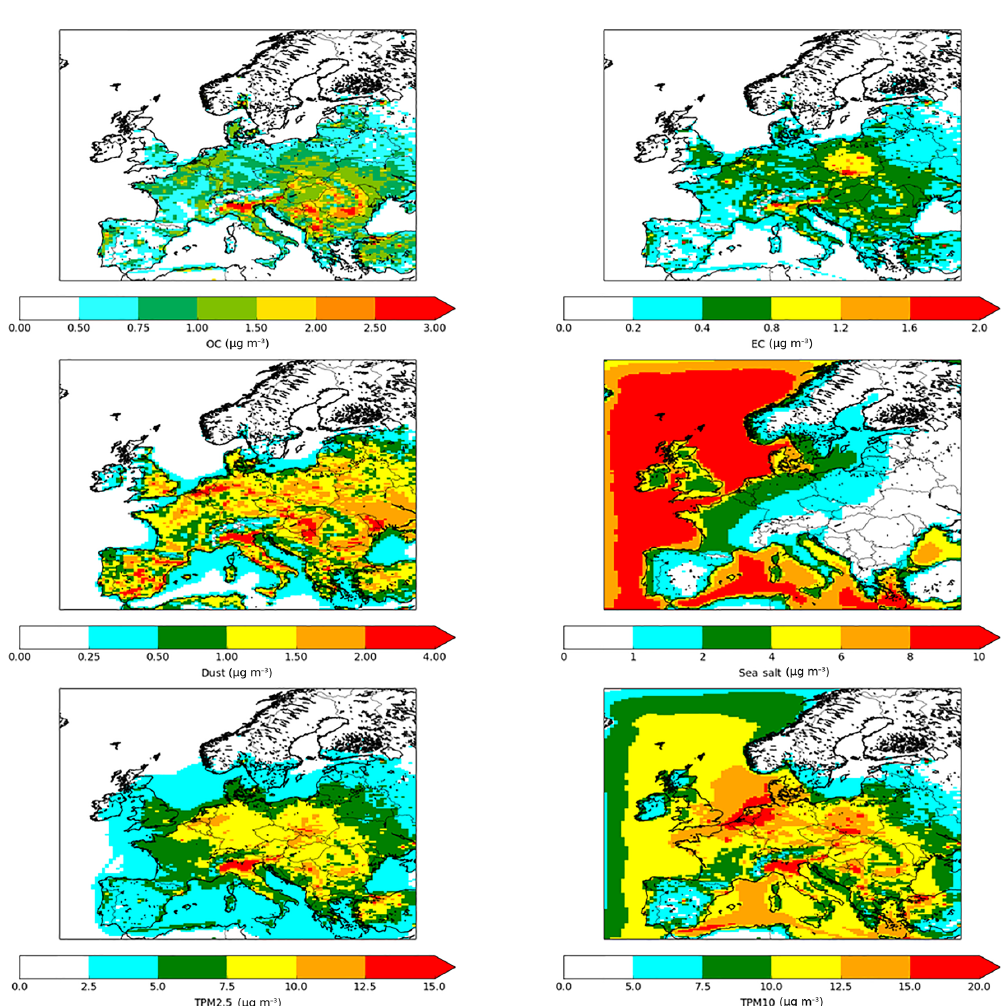
Figure 3. Annual mean surface concentrations for several model species. Note the difference in scaling between the different species and the nonlinear scaling for several